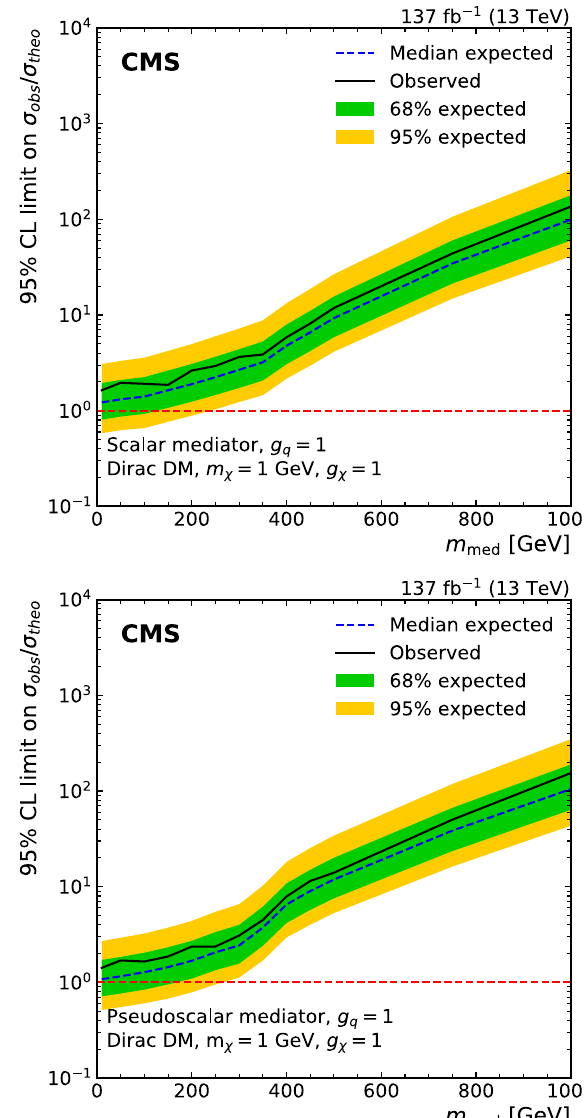
Fig. 6 The 90% CL DM-nucleon upper limits on the cross section for simplified DM in the spin-independent (upper) and spin-dependent (lower) cases. The coupling to quarks is set to g q = 0 . 25 and the coupling to DM is set to g χ = 1. Limits from the XENON1T [93], LUX [94], PandaX-ll [95], CRESST-III [96], and DarkSide-50 [97] experiments are shown for the spin-independent case with vector cou- plings. Limits from the PICO-60 [98], PICO-2L [99], IceCube [100], and Super-Kamiokande [101] experiments are shown for the spin-